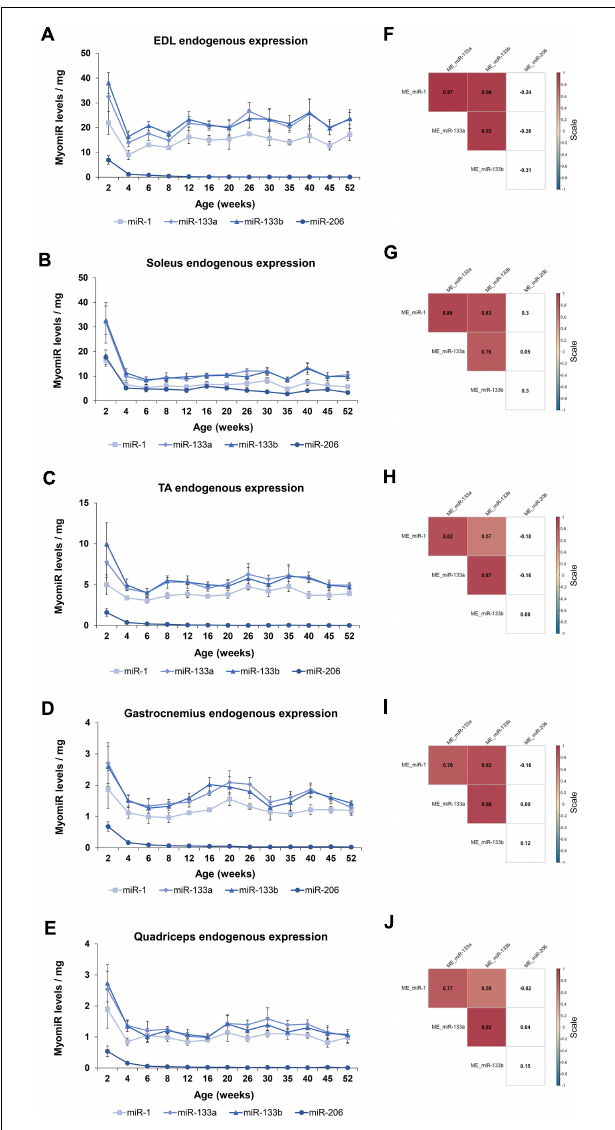
FIGURE 6 | Endogenous expression levels of the four myomiRs associate to the skeletal muscle growth. The endogenous myomiR levels were further normalized to the skeletal muscle weights across all the ages. (A–E) At the 2-week time-point (early postnatal stage) the normalized endogenous myomiR levels were found to be increased for all the skeletal muscles. During adolescence and adulthood their endogenous levels were identified to be decreased and remained at a constant low level. (A) EDL tissue was found to express the highest amount of myomiR levels per muscle weight compared to the rest of the tissues. The two heaviest tissues, (D) gastrocnemius and (E) quadriceps, were determined to express the lowest myomiR levels per muscle weight. Normalized endogenous miR-206 abundance remained at high levels in (B) soleus for all the ages. Data on illustrations represent the mean values ± SEM. (F–J) Heatmaps of the correlation coefficients were generated using the Spearman method. The three myomiRs, miR-1, miR-133a, and miR-133b showed significantly positive correlations between them for all the skeletal muscles, whereas miR-206 was uncorrelated with the other three myomiRs. Correlation (rho) values are shown within the squares and those close to +1 (red) denote a strong positive correlation, and values close to –1 (blue) a strong negative correlation. Correlation values with no significance are in white. p < 0.05; ME: